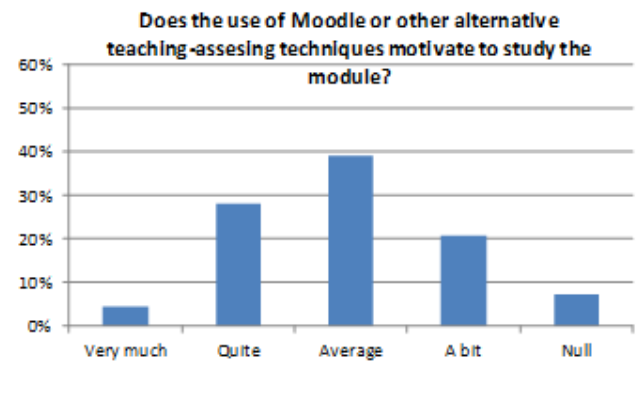
Figure 10. Opinion of the students on the lecturing and assessment techniques introduced